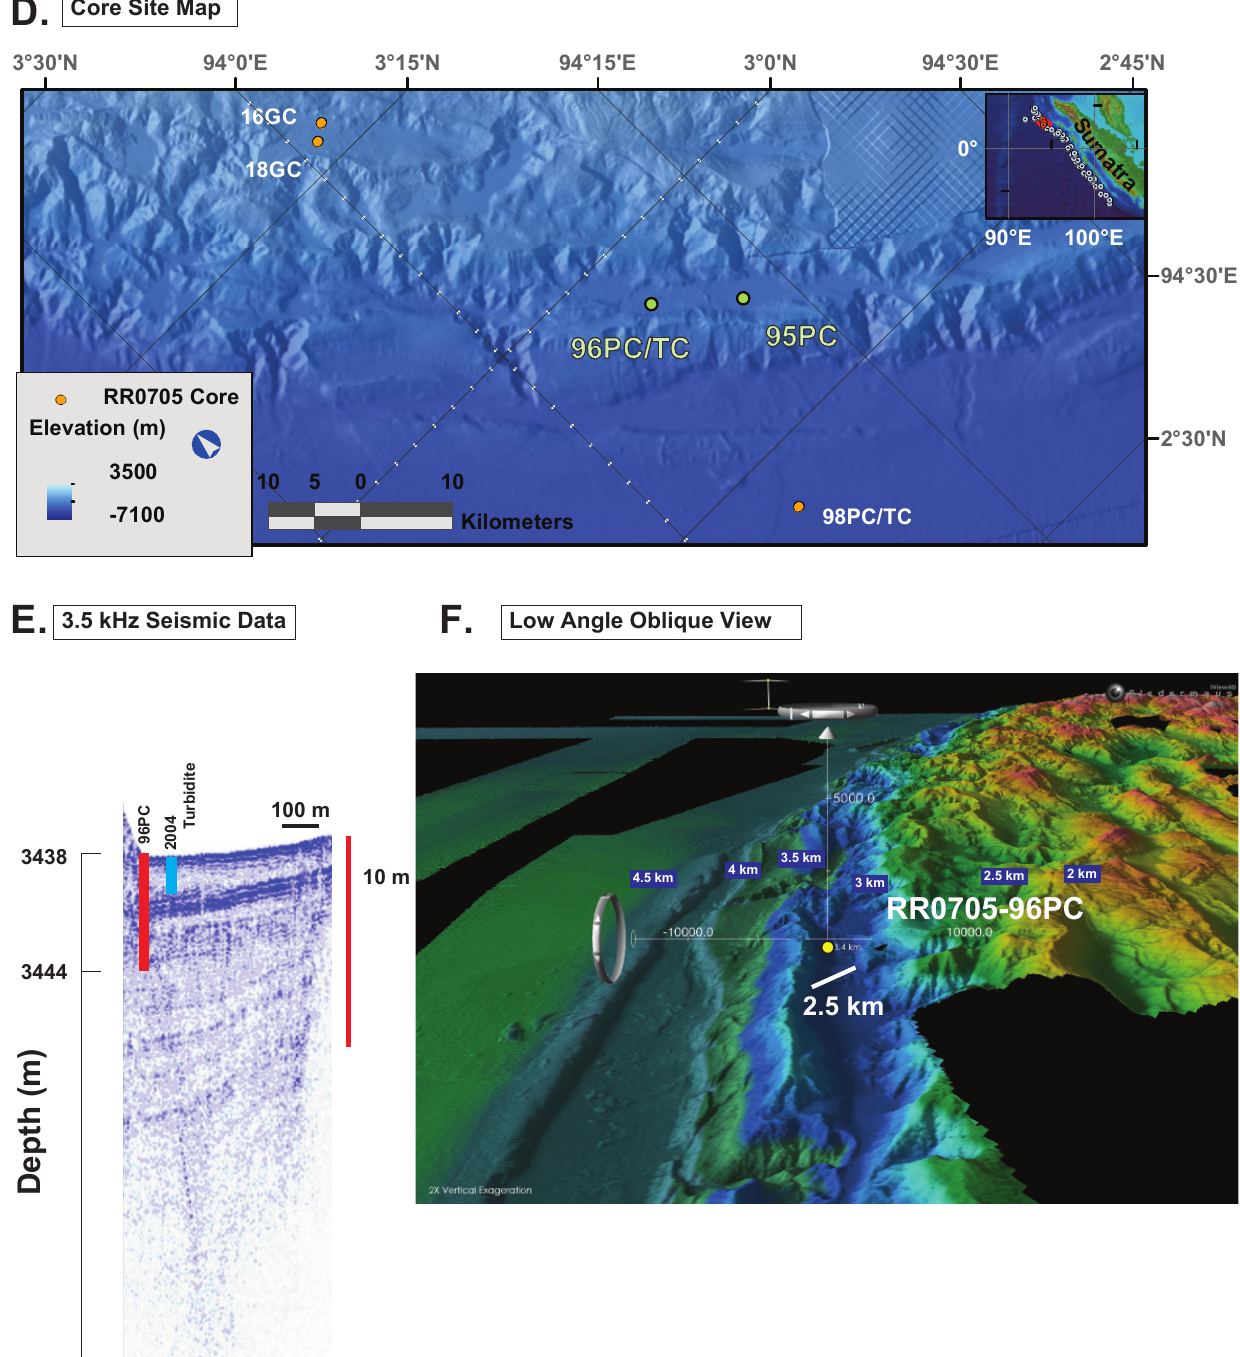
Fig. 6. (D) Core site locations for cores RR0705-96PC/TC. Inset map shows location of large map in red (northern margin) and cores in main map are orange dots (E) 3.5kHz CHIRP seismic data collected at core sites are processed in SioSeis and plotted in SeiSee (seismic envelope). Core location is designated by a red line scaled to core length. (F) Low angle oblique view of core site, designated by yellow dot. Due to nature of oblique maps, the scale is only relevant nearest the core